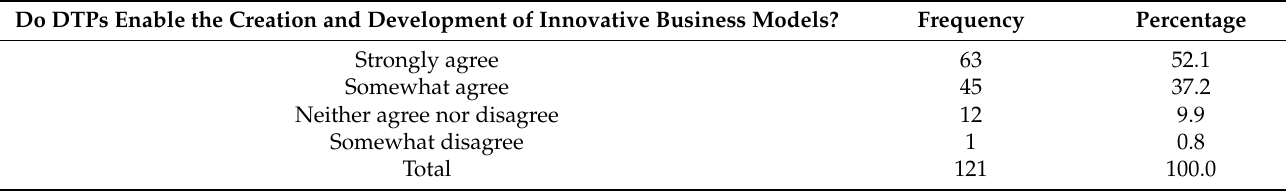
Table 2. DTPs as tools for establishing and developing innovative business models. Do DTPs Enable the Creation and Development of Innovative Business Models?